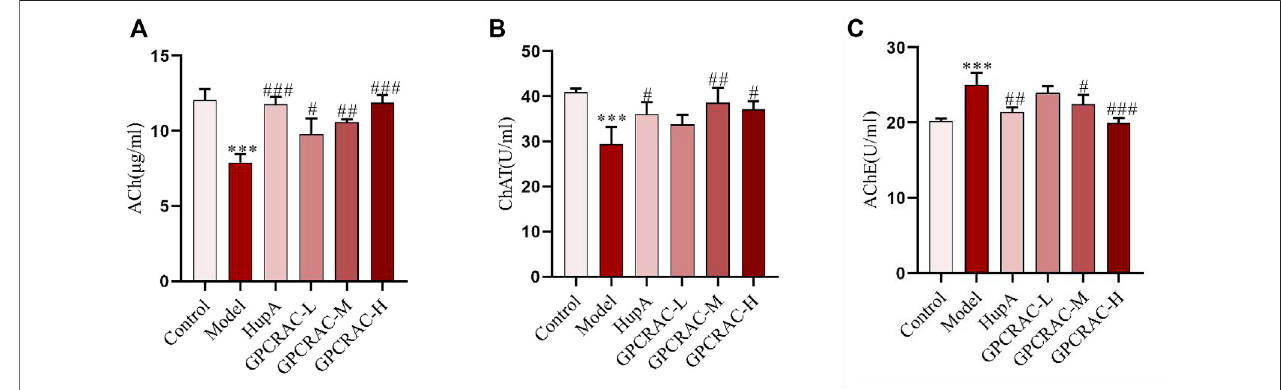
FIGURE 2 | Ameliorating effect of GPCRAC extracts on cholinergic system dysfunction in hippocampus of scopolamine-induced cognitive de fi cit mice. Ach content (A) , ChAT activity (B) and AchE activity (C) in hippocampus were measured according to assay kit instructions; Data are expressed as mean ± SE. * p < 0.05, ** p < 0.01 and *** p < 0.001 compared to the control group; # p < 0.05, ## p < 0.01 and ### p < 0.001 compared to the scopolamine-treated group ( n =